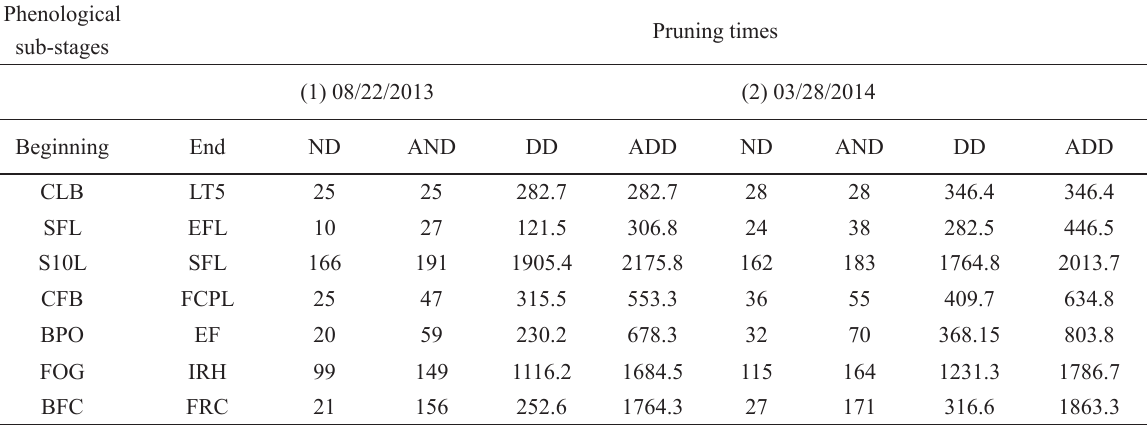
Duration (days) and temperature requirements (degree-days) for the phenological sub-stages of sugar-apple following different pruning times (1 and 2) in Janaúba, Minas Gerais, Brazil,